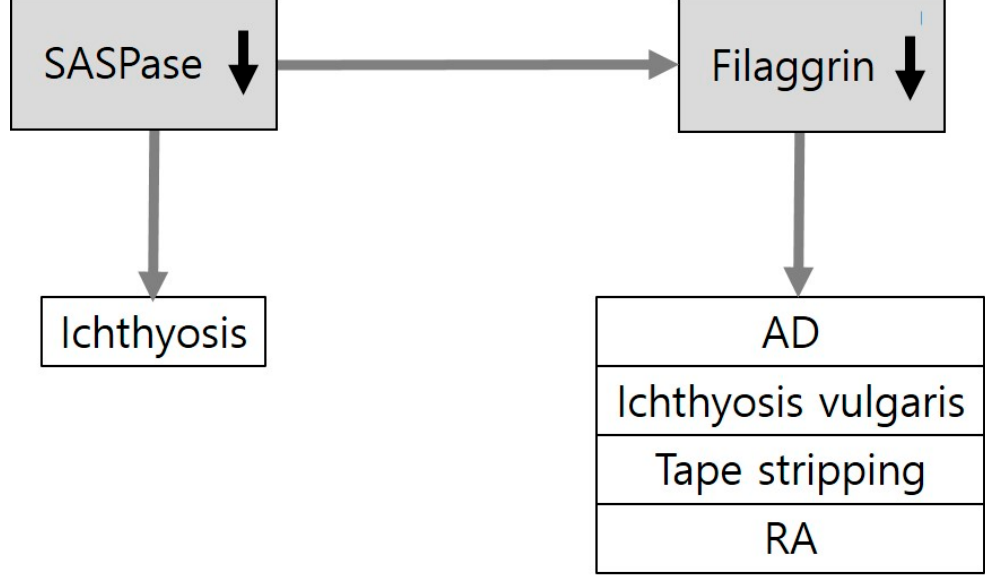
Figure 2. Downregulation of filaggrin in skin diseases and experimental conditions related to epidermal barrier dysfunction. Loss-of-function mutations of FLG (encoding filaggrin) are associated with skin disorders related to barrier dysfunction, including atopic dermatitis (AD) and ichthyoses. Expression levels of filaggrin have also been reported to be reduced in experimental conditions of the disrupted epidermal barrier by tape stripping or retinoic acid (RA) application. SASPase (skin aspartic protease) generates filaggrin monomers from profilaggrin. Loss-of-function mutations of SASPase are associated with ichthyosis in dogs.